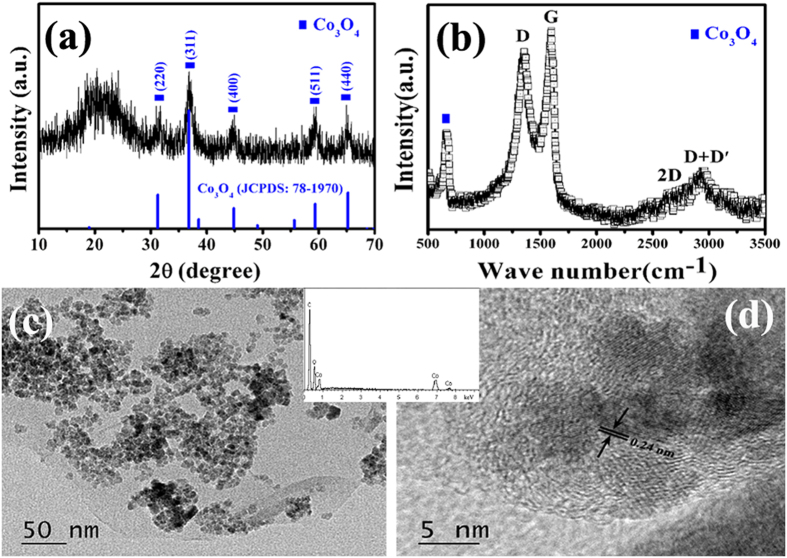
(a) XRD pattern, (b) Raman spectrum, (c) TEM image, and (d) HRTEM image of Co3O4/RGO (inset: EDS result).